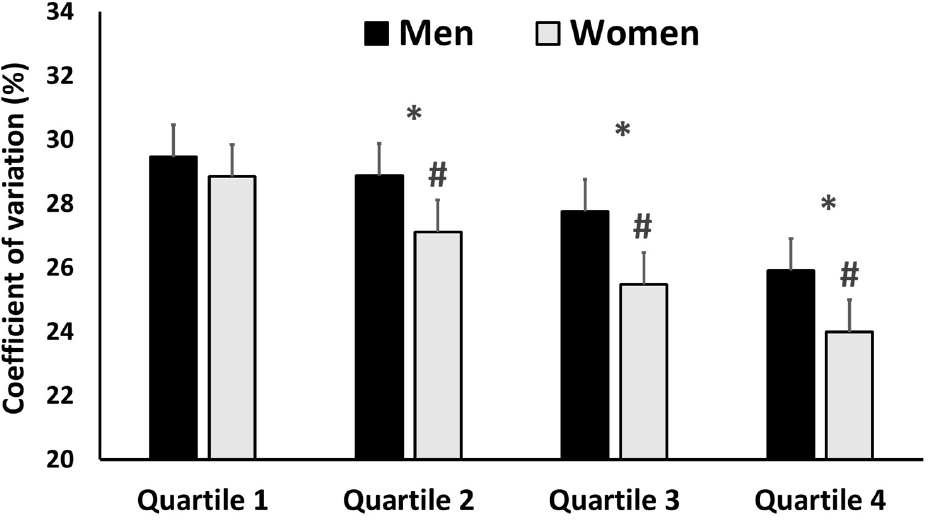
Figure 3. Coefficient of variation of the segment speeds for males ( ♂ , n = 4380) and females ( ♀ , n = 1276) who participated in the 2017, 2018, 2019, and 2021 editions of the OCC ® , according to their performance levels (Quartile 1–Quartile 4). * Significant differences with the next quartile (i.e., Q1 to Q2, Q2 to Q3, and Q3 to Q4); # significant differences between males and females.